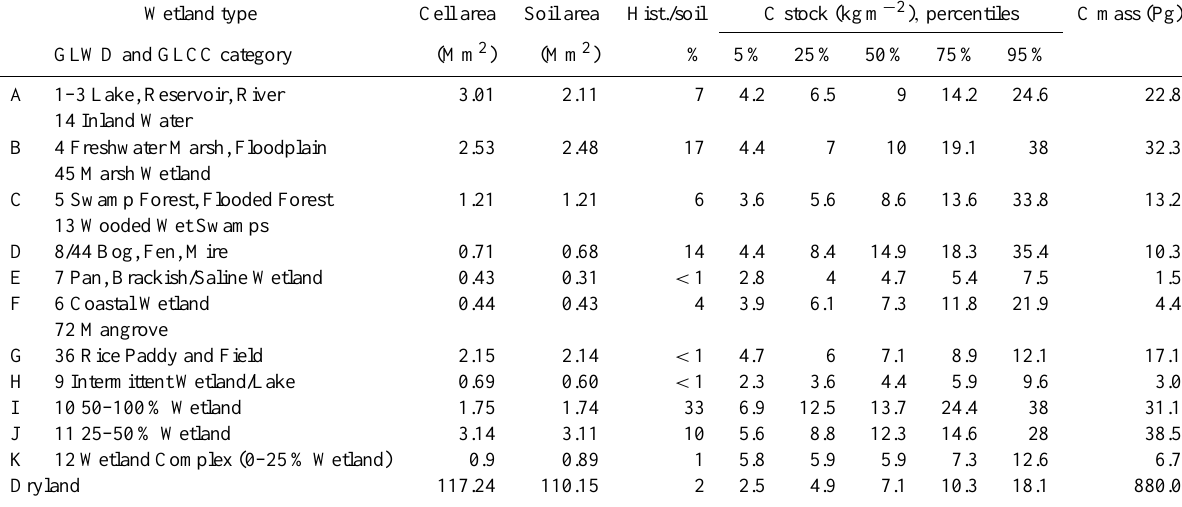
Table 7. Organic carbon stocks and masses in the top 1m of global wetland soils derived from the HWSD v.1.1-adjusted. Wetland extent is primarily defined according to the Global Lake and Wetlands Database (1–12), augmented by wetland in the GLCC (13–72). Percentiles refer to the distribution of C stocks in each grid cell within the soil area mentioned. SOC mass of permanent wetlands (types B–I) is 81.8Pg; that of all wetlands except open waters (types B–K) is 158.1Pg. 1Mm 2 = 10 6 km 2 . Hist/soil: fraction of soil area covered by Histosols.